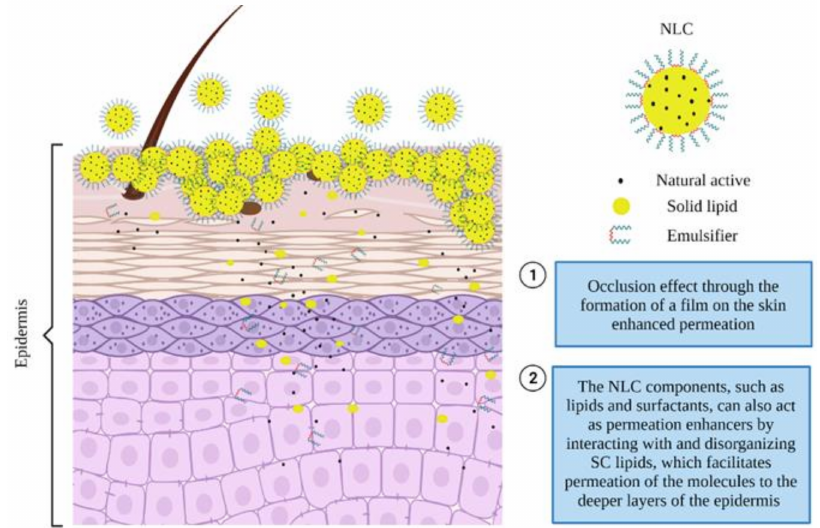
Figure 5. Permeation and penetration of nanostructured lipid carriers in the skin after topical